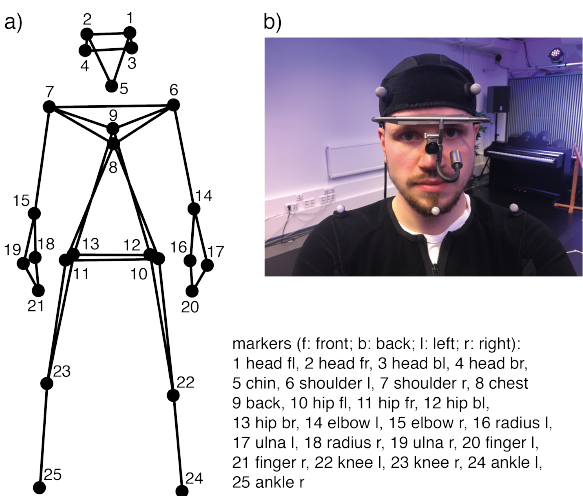
Figure 1. a) Mocap markers as a schematic representation and b) mocap markers and eye tracker attached to participant.